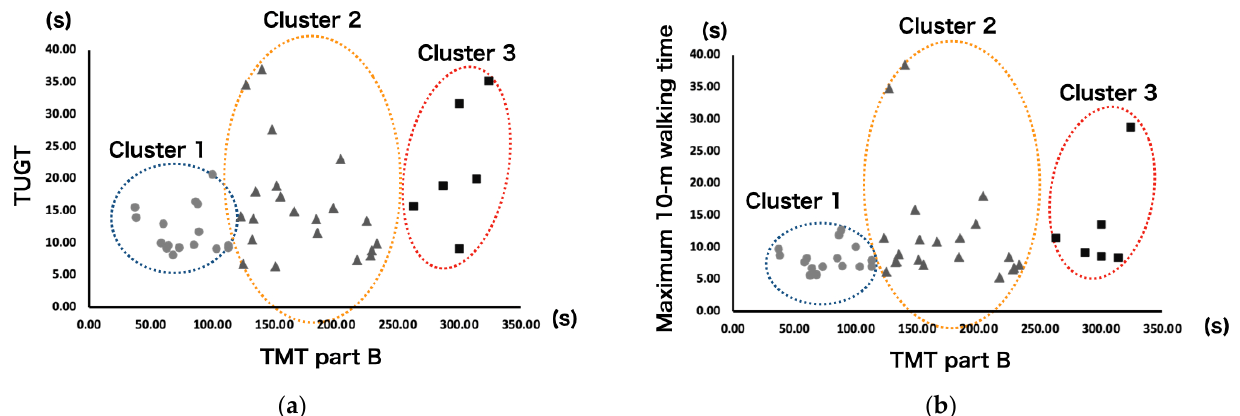
Figure 1. ( a ) Illustration of the Trail Making Test Part B and Timed Up and Go Test. Gray dots indicate cluster 1. Dark gray dots indicate cluster 2. Black dots indicate cluster 3. Cluster 1 showed better TUGT score than cluster 3 ( p = 0.002). Cluster 2 showed better TUGT score than cluster 3 ( p = 0.016). ( b ) Illustration of the Trail Making Test Part B and maximum 10 m walking speed test. Gray dots indicate cluster 1. Dark gray dots indicate cluster 2. Black dots indicate cluster 3. Cluster 1 showed better 10 m walking than cluster 3 ( p = 0.024).